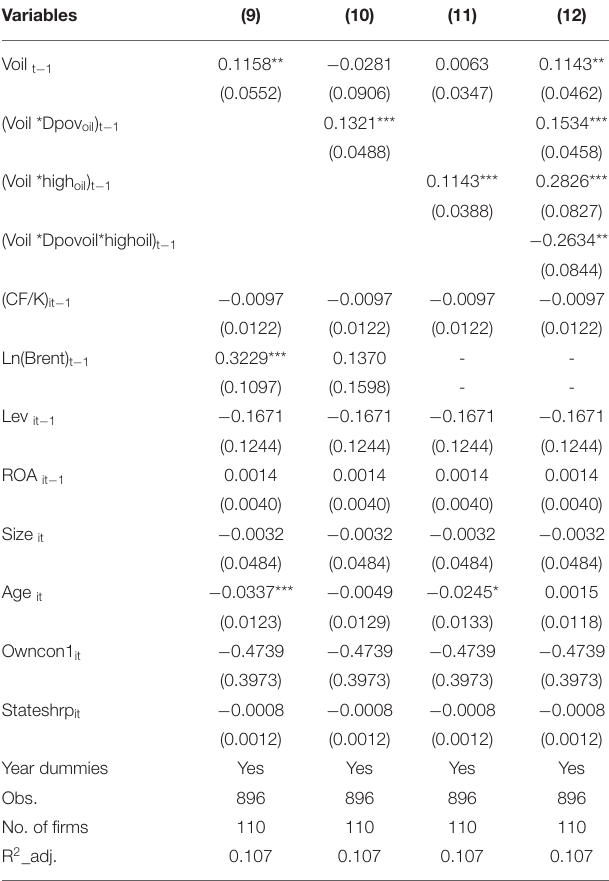
TABLE 5 | The impact of oil price uncertainty on inefficiency